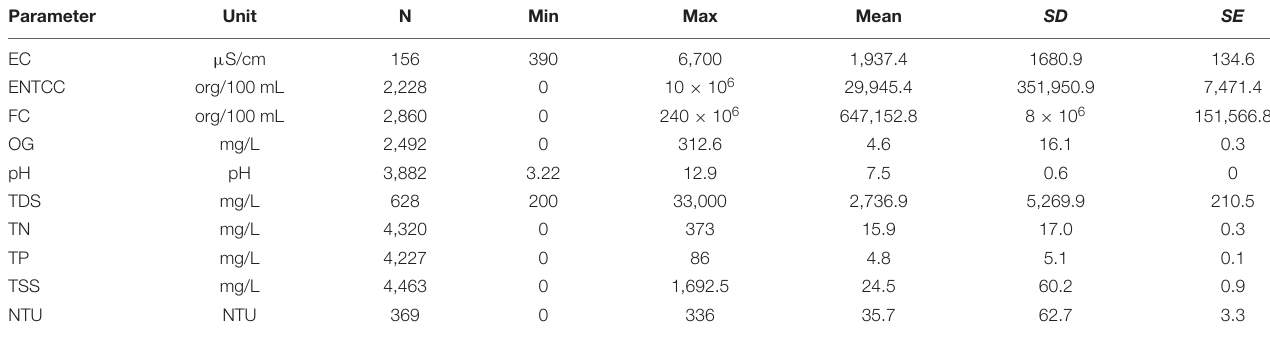
TABLE 2 | Summary statistics of assessed